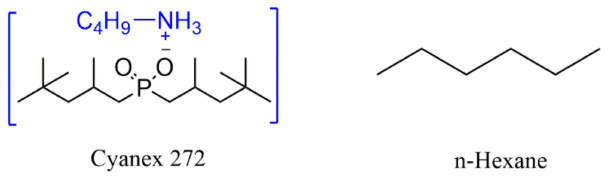
Figure 1. Structure of extractant and diluent.